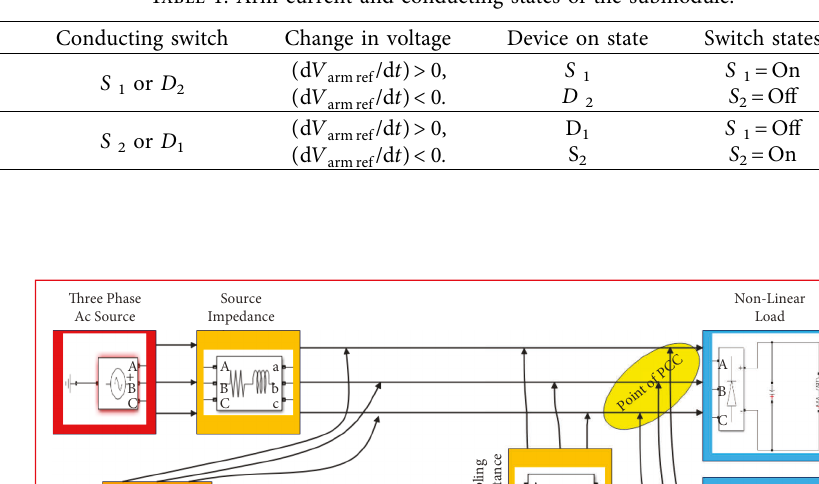
Table 1: Arm current and conducting states of the submodule.